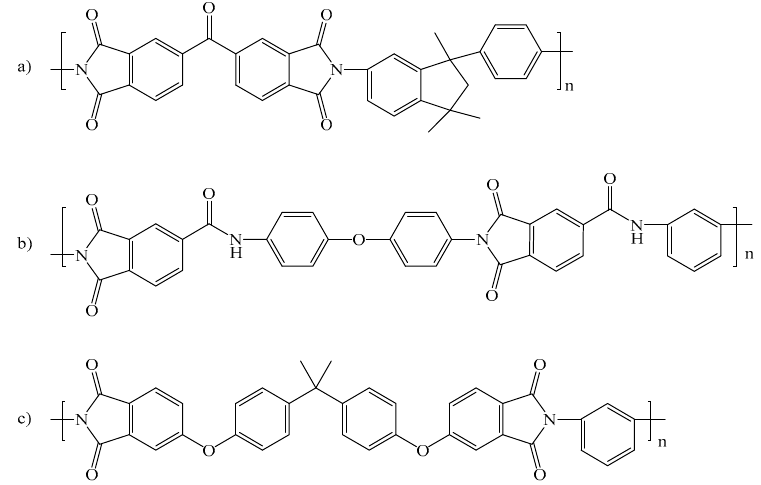
Figure 22. Chemical structures of polyimides: ( a ) Matirmid ® 5218, ( b ) Torlon, and ( c ) Ultem. Bos et